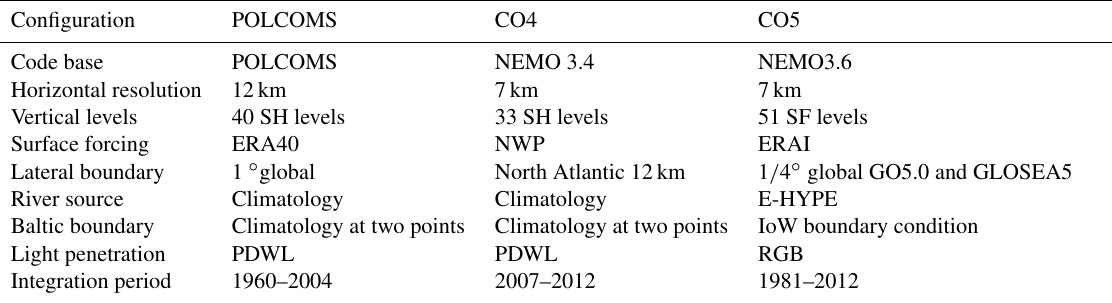
Table 1. Key configuration differences.